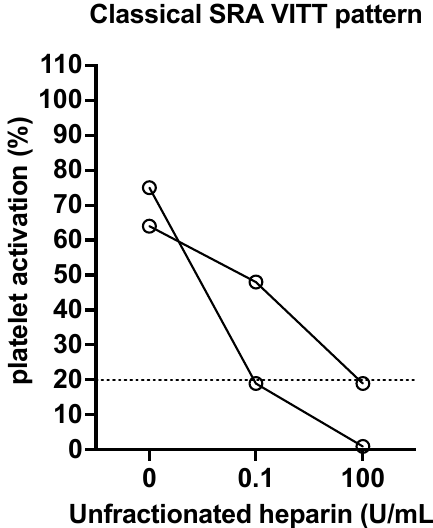
Figure 5. Two examples of a classical pattern expected for VITT-positive (Westmead Hospital) cases assessed by SRA. Platelet activation should occur in the absence of added heparin. In the presence of added heparin at a therapeutic level (0.1 U/mL final concentration in these examples; 0.5 U/mL may lead to even greater inhibition), platelet activation, measured as serotonin release, may be inhibited. In the presence of added heparin at a supra-therapeutic level (100 U/mL final concentration in these examples), platelet activation, measured as serotonin release, is further inhibited (i.e., very little or no release occurs). Occasionally, however, platelet activation may also occur in the presence of added therapeutic heparin, thereby challenging the discrimination between VITT and